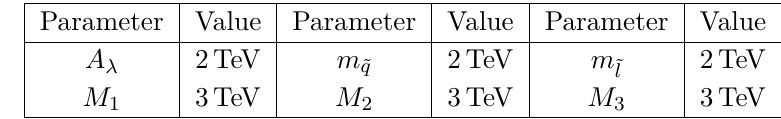
, and M (i=1,2,3) are i l